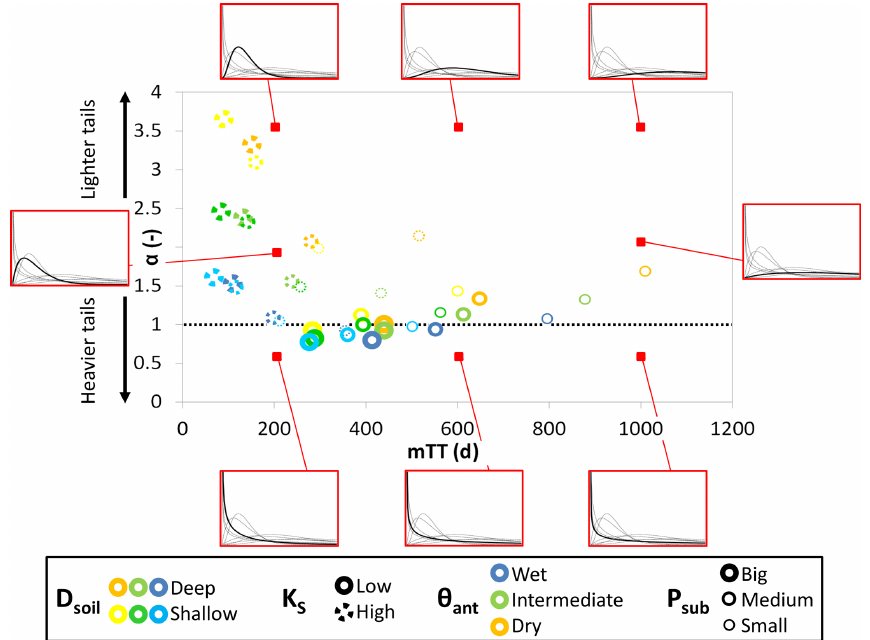
Figure 9. Gamma shape parameters ( α ) and mean transit times (mTTs) for individual scenarios with different combinations of catchment and climate properties. The red boxes contain exemplary gamma distributions with shape and scale corresponding to the red dot location. The dotted black line marks the shape parameter value of 1 that corresponds to an exponential